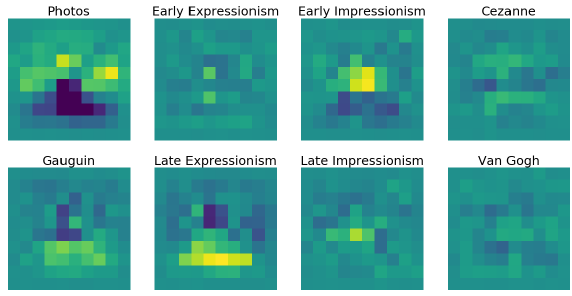
Figure 17. Accumulated fixation heatmaps over all 240 images in each style. The heatmaps are normalized and the grand spa- tial bias is